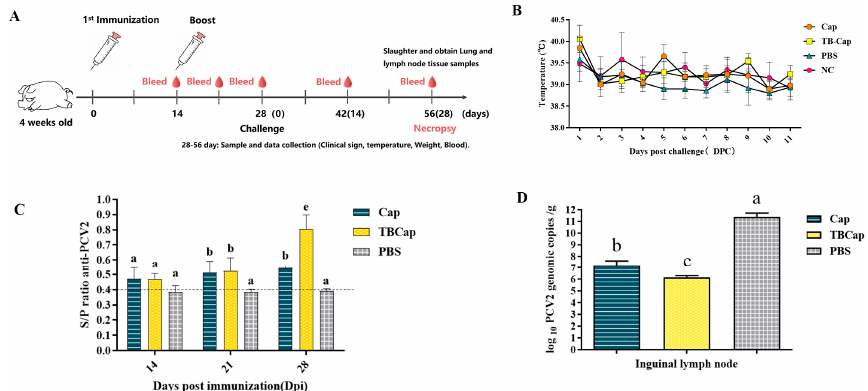
Figure 5. Research on immunogenicity and attack protection tests in piglets. ( A ) Piglet immunization strategy. ( B ) Changes in piglet body temperature after challenge. ( C ) ELISA for PCV2-specific antibodies in piglets after immunization (S/P). ( D ) Lymph node virus load in piglets at autopsy. Different superscripts (a, b, c, e) indicate statistically significant differences in lymph node viral load between the test groups ( p < 0.05).